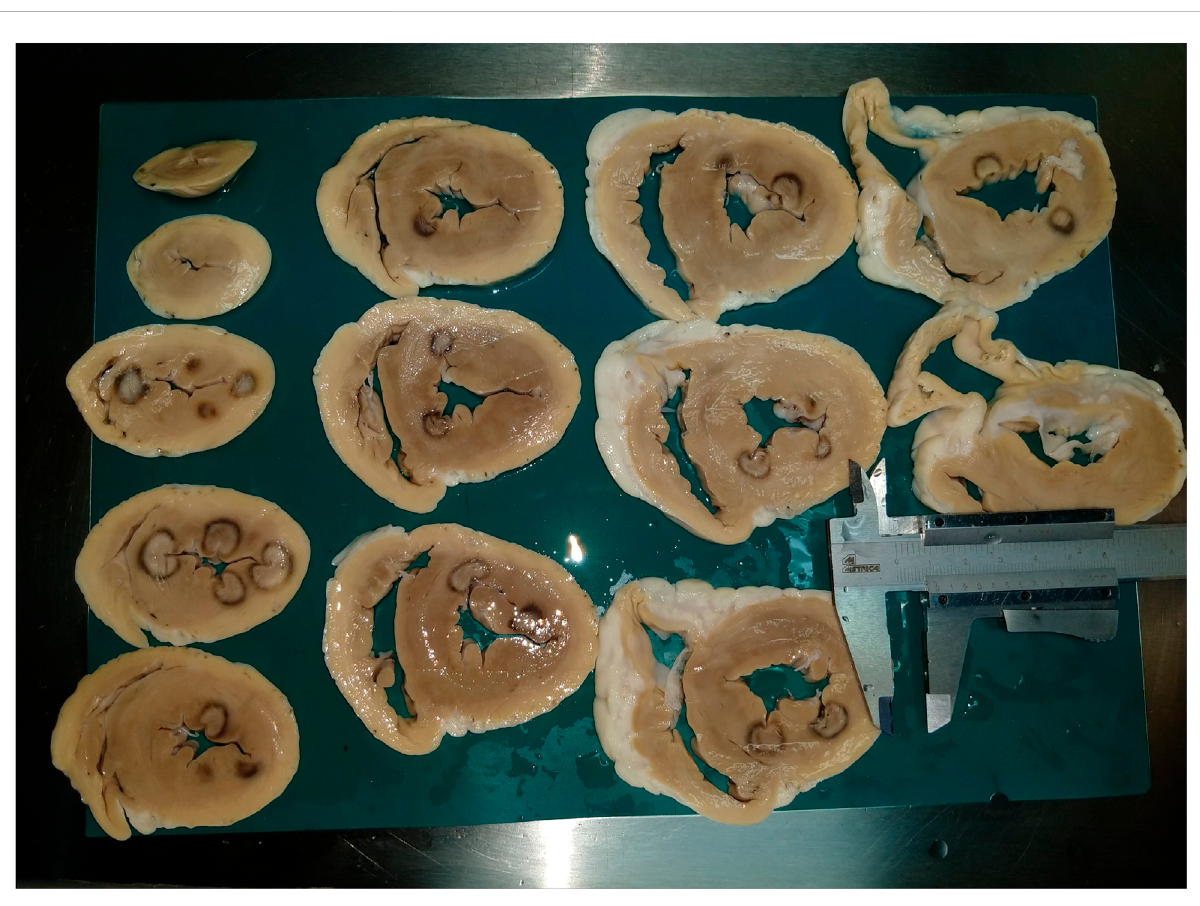
FIGURE 5 Example of a pathological picture used for measurement of radiofrequency lesions. On the picture you can see 13 subsequent transverse sections oftheleftventricle. Radiofrequencylesionsarevisible.Thereisacaliper showingtheexactly1 cm, which wasusedto calibratethesoftware